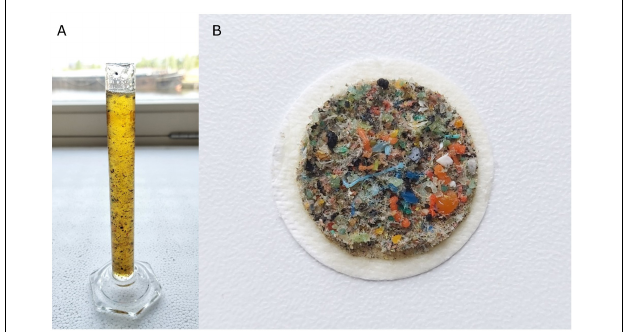
different plastic shapes, sizes, and